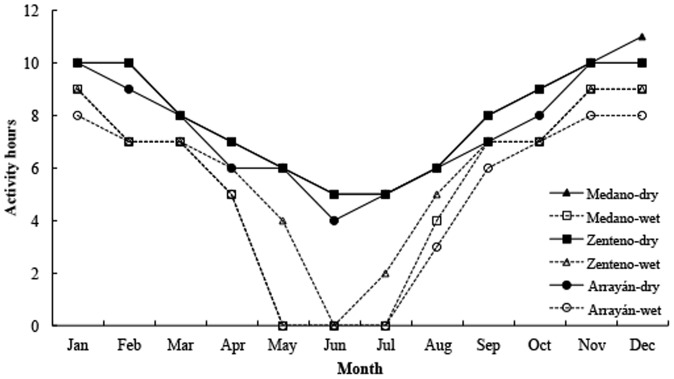
Monthly predicted hours of activity for lizards in Medano, Zenteno, and Arrayán, on dry (terrestrial, filled symbols) and wet (intertidal, empty symbols) conditions.